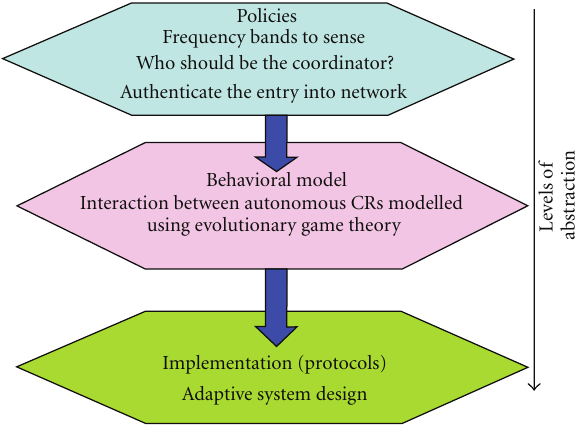
Figure 1: Levels of